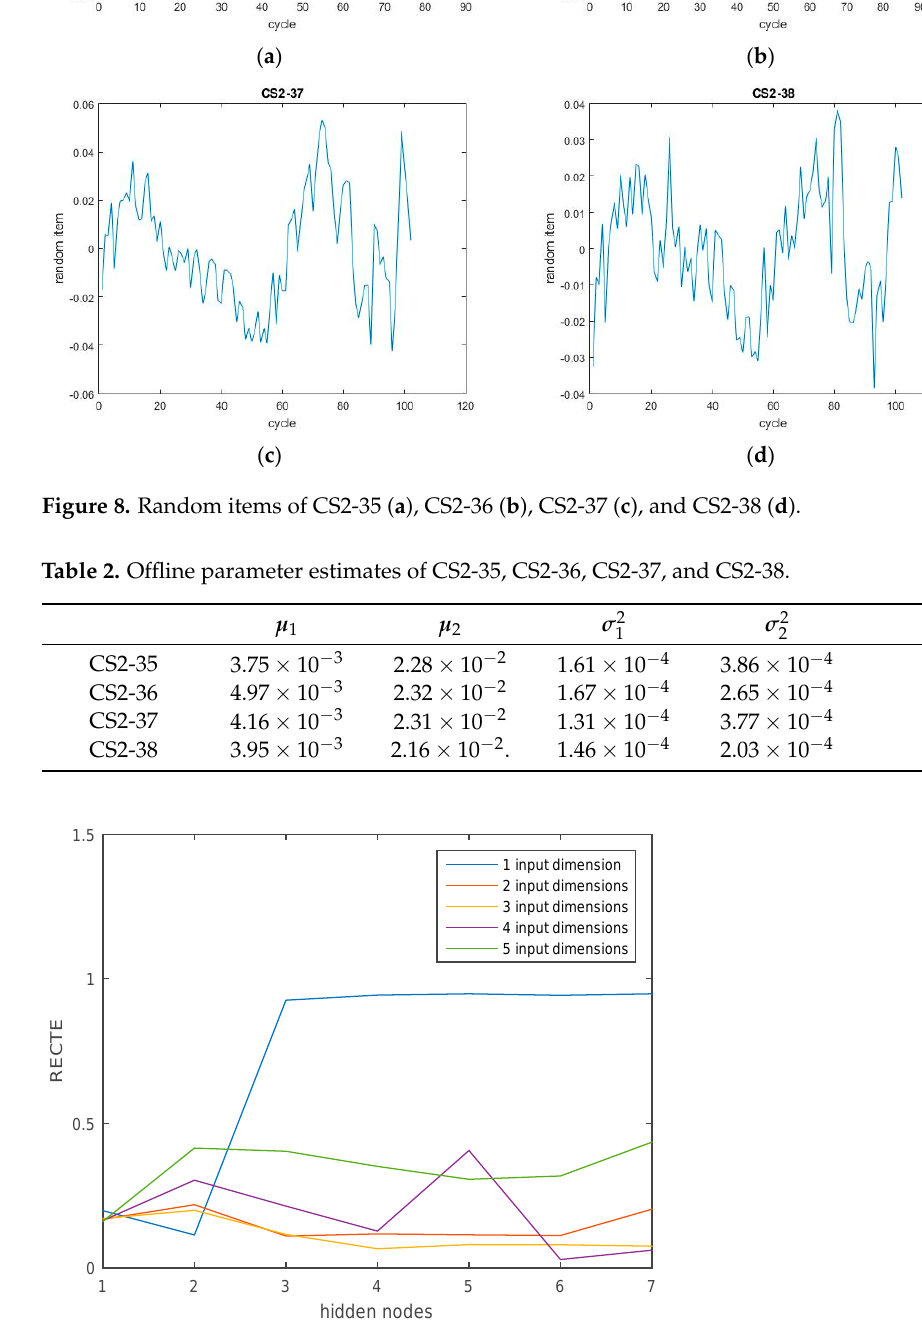
Figure 9. RECTE of ELM with different input dimensions and hidden nodes.